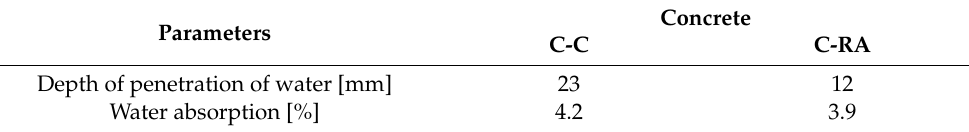
Table 9. Depth of penetration of water